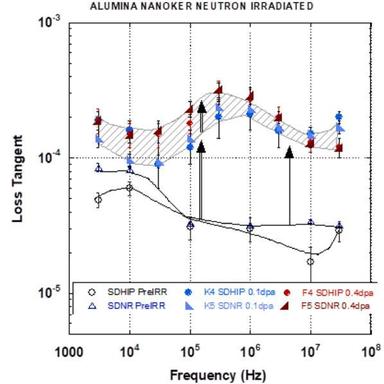
Comparison of loss tangent of the present neutron irradiated alumina samples with unirradiated reference materials.